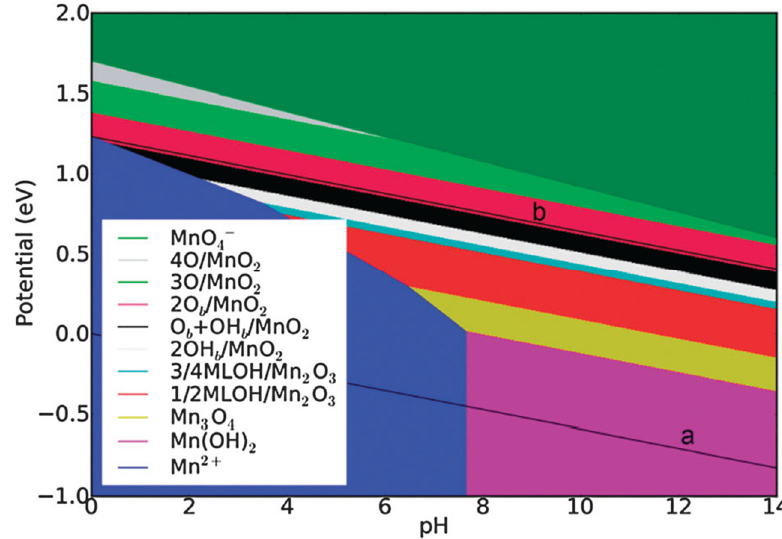
Figure 18. General surface Pourbaix diagram for MnO x catalysts. The oxidation state of the surface and the ORR and OER potential are constant versus the reversible hydrogen electrode (RHE). Lines a and b represent the RHE line and the O 2 /H 2 O equilibrium line. (Reprinted from ref. [136] with permission from the Physical Chemistry Chemical Physics. Copyright © 2012, Royal Society of Chemistry).